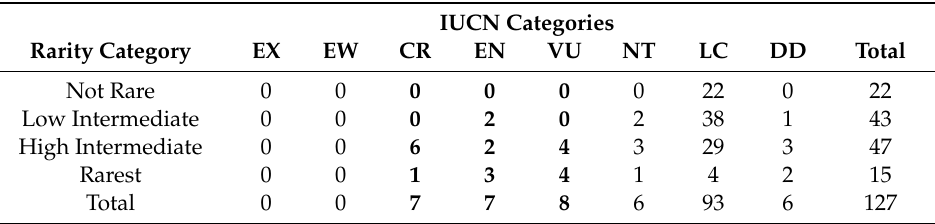
Table 1. Categories of rarity (based on Rabinowitz [10]) of New World pitvipers in relation to the categories of the IUCN. CR = Critically endangered; DD = data deficient; EX = extinct; EW = extinct in the wild; EN = endangered; LC = least concern; NT = near threatened; VU = vulnerable. Numbers for threatened categories (CR, EN, and VU) are in bold. IUCN Categories